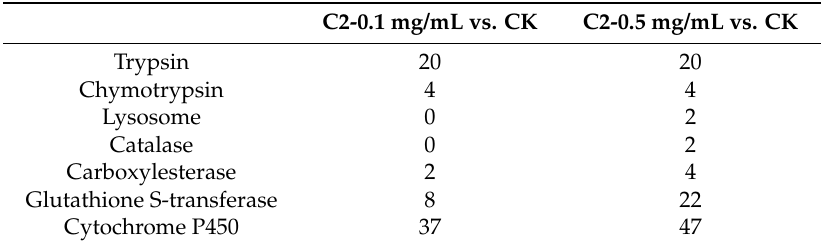
Table 4. Number of differentially expressed genes of detoxification and protective enzymes in H.